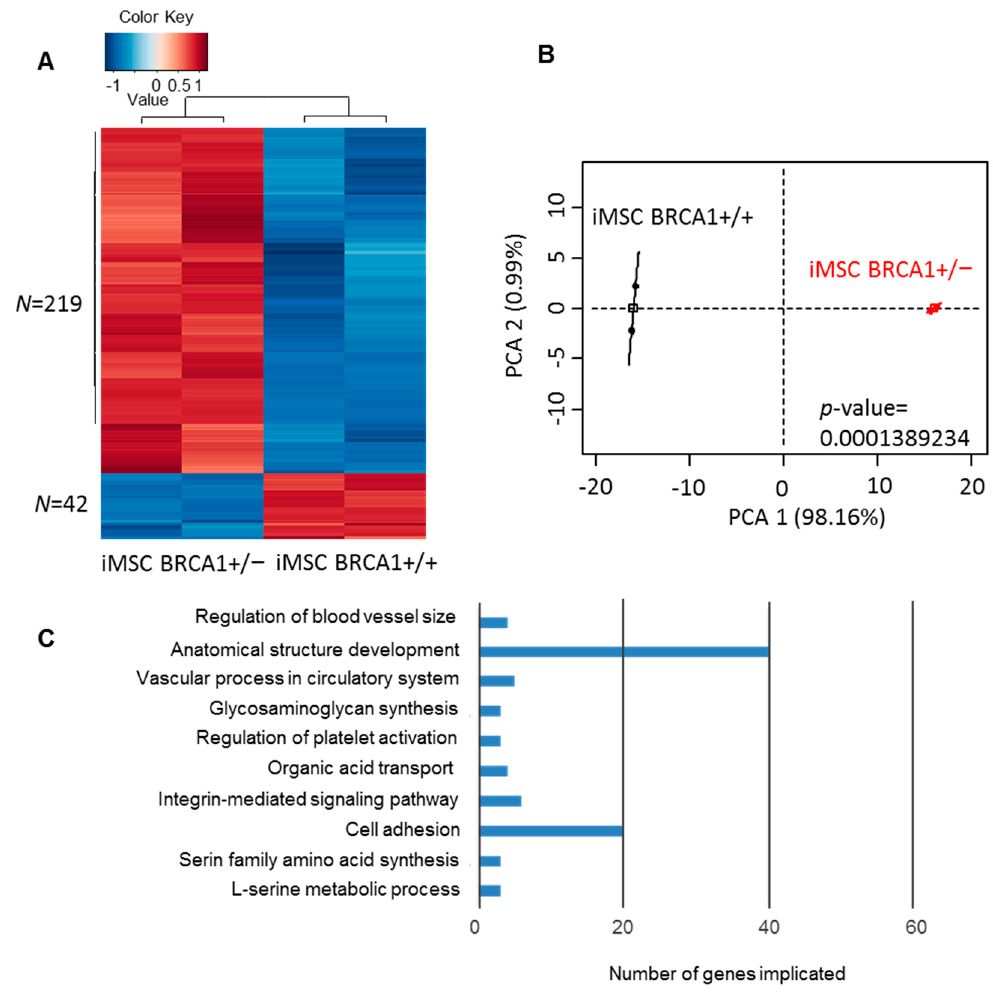
Figure 2. Differentially expressed genes between BRCA1 +/ − and BRCA1 +/+ iMSCs. ( A ) Transcriptome heatmap with unsupervised classification of genes with differential expression between BRCA1 +/ − and BRCA1 +/+ iMSCs. ( B ) Principal component analysis of genes with differential expression between BRCA1 +/ − and BRCA1 +/+ iMSCs. ( C ) Functional enrichment in Gene Ontology Biological Processes of genes that were upregulated in BRCA1 +/ − iMSCs compared to BRCA1 +/+ iMSCs.